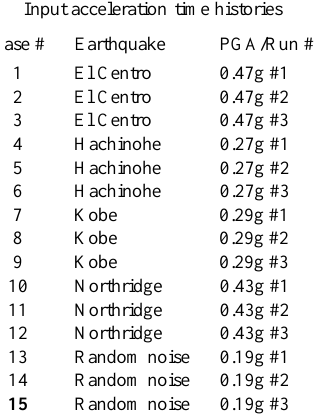
Table 2 Input acceleration time